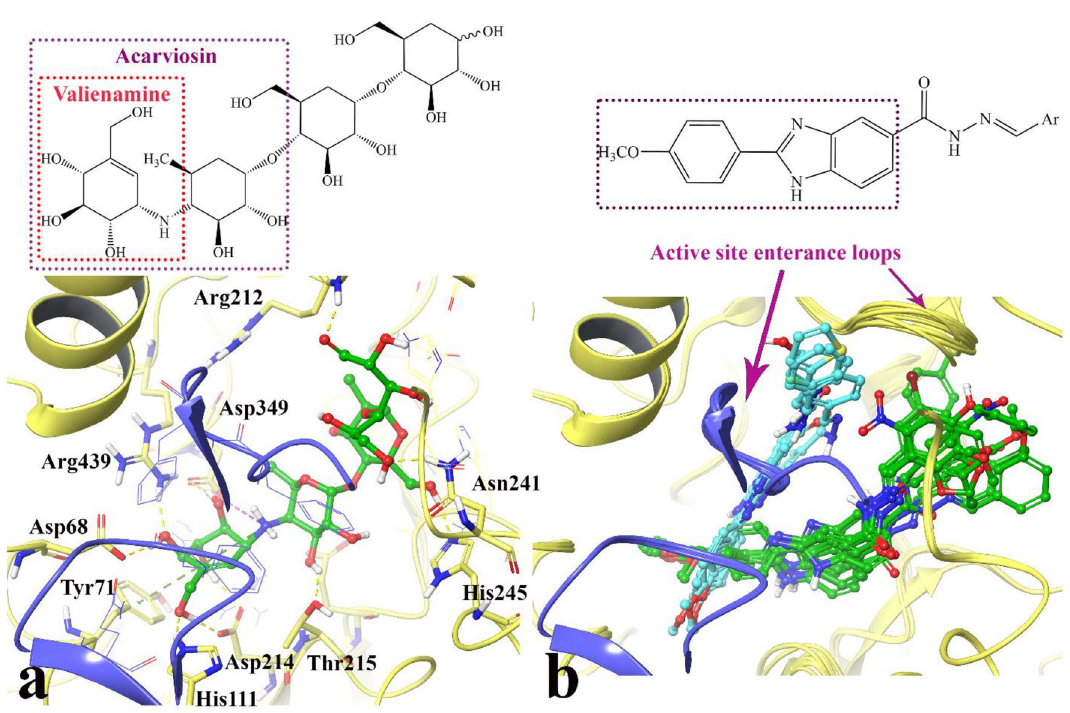
Figure 3. Induced fit docked representation of acarbose ( a ) and the superimposed of the synthesized compounds ( b ). The N-terminal domain and the subdomain of the α-glycosidase are colored in yellow and blue, respectively. Compounds 8p , 8a , 8h , and 8f with lower steric size shown in cyan color while compounds 8d , 8g , 8e , 8c , 8b , 8m , 8k , 8n , 8l , and 8o with higher steric size shown in green